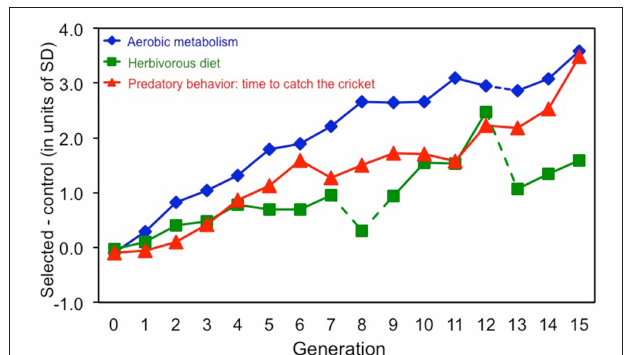
FIGURE 1 | Direct effects of 15 generations of selection on bank voles toward: high swim-induced aerobic metabolism, herbivorous capability measured as ability to maintain body mass on a low-quality diet, and predatory propensity measured as ranked time to attack a cricket. Comparison of the cumulative effects of selection in the three directions is expressed as a difference between the means of four selected (in each direction) and four control lines, expressed in units of phenotypic standard deviation. In generation 8 and 13 the food composition used in selection trial in the “Herbivorous” lines was different than in other generations, which resulted in the irregular pattern (marked with broken lines). In generation 12 selection in “Aerobic” lines was relaxed (broken line).